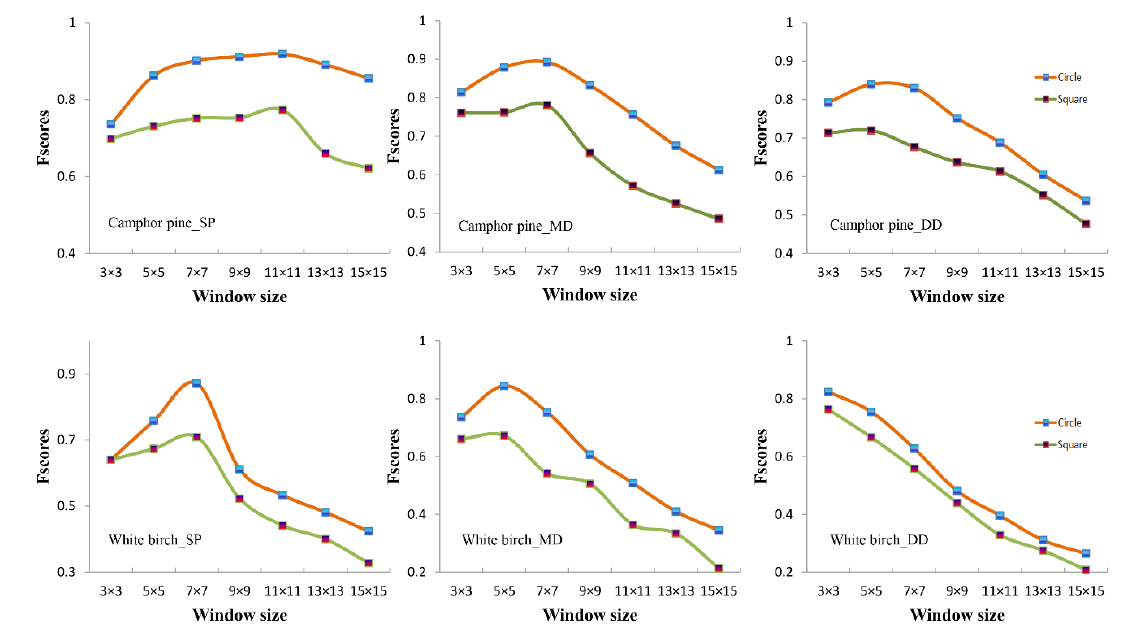
Figure 10. Treetop-detection accuracy of various window size and shape at different density states and forest species. The yellow line refers to the F-scores of treetop detection with various circle window sizes; the green line refers to the F-scores of treetops detected using various square window sizes.